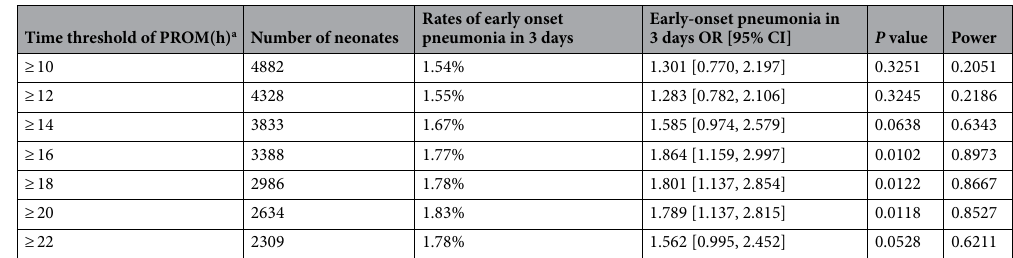
Table 2. Multivariable analysis of length of time of PROM and neonatal outcomes: adjusted OR of other factors at time thresholds with significant differences of early-onset pneumonia in 3 days according to length of time of PROM. Controlling for the city where the hospital locates, the mother’s age, education level, chorioamnionitis, induction of labor, prenatal antibiotic treatment, mode of delivery, amniotic fluid pollution, neonate’s sex, Apgar Score. a Length of time of PROM from 0 h through specific time threshold.